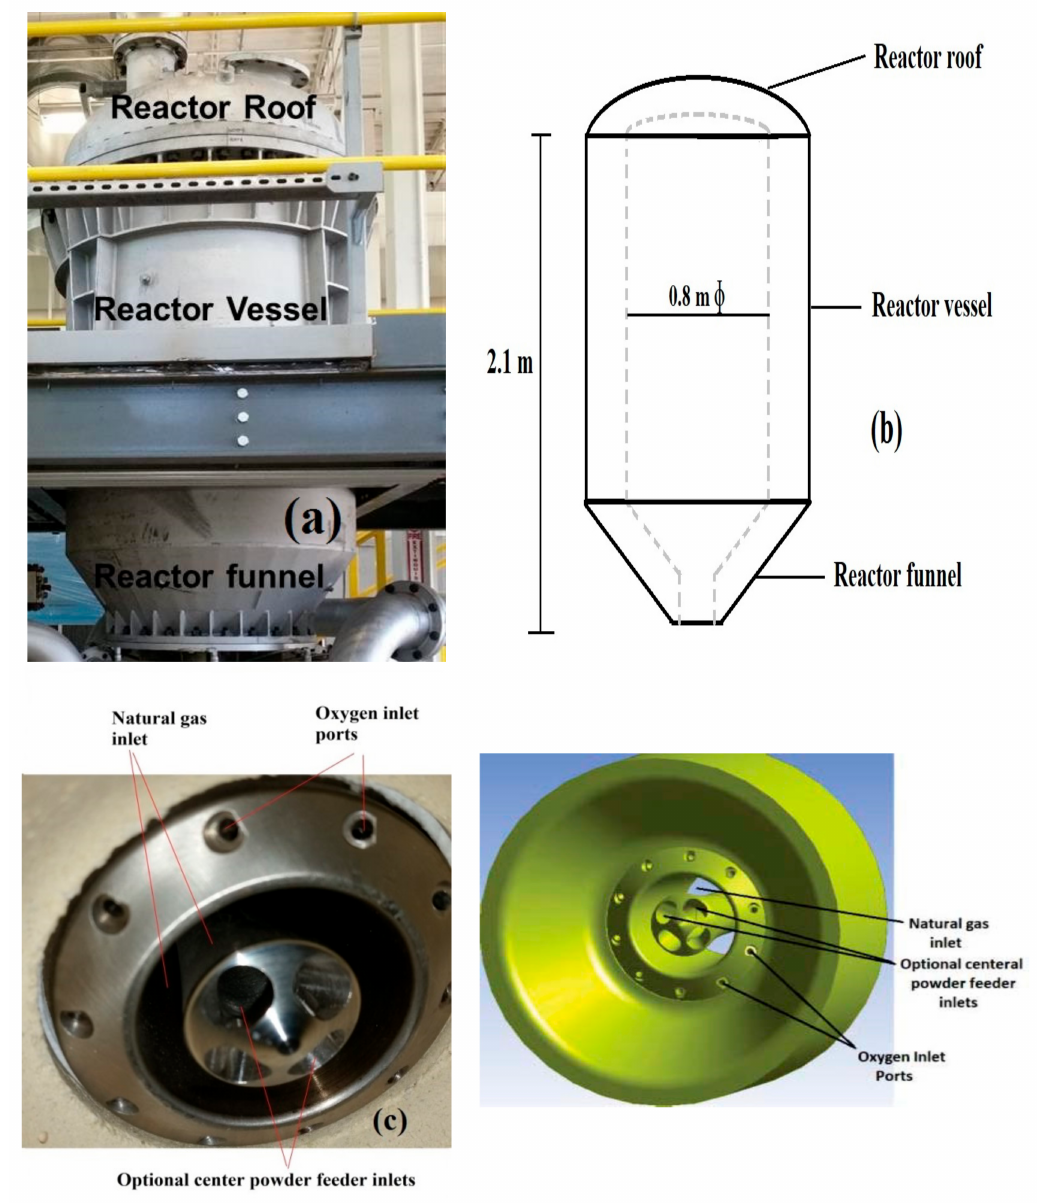
Figure 14. ( a ) The Large-Scale Bench Reactor (LSBR) Vessel, ( b ) Schematic diagram of the LSBR, ( c ) The burner for the LSBR, and Schematic of the burner ( Lower right